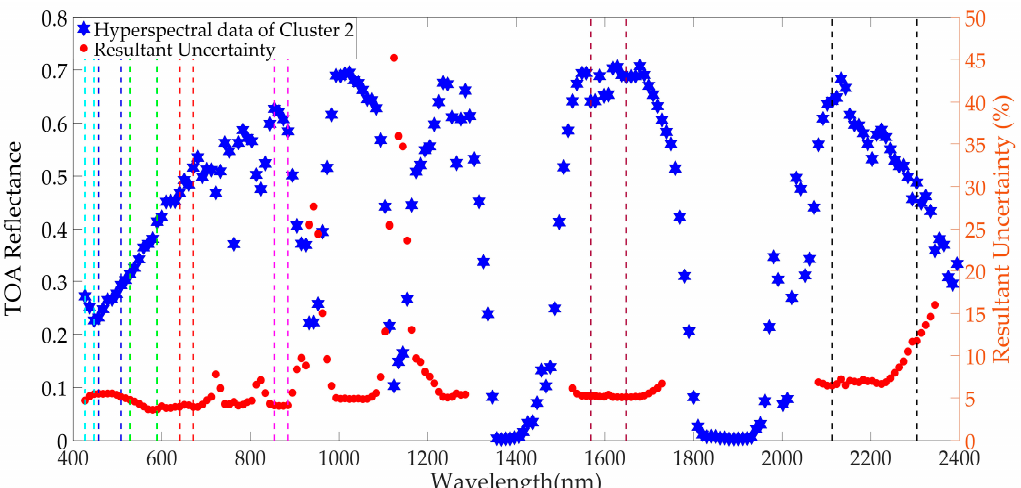
Figure A1. Estimated representative hyperspectral profile of Cluster 2 and its resultant uncertainty.